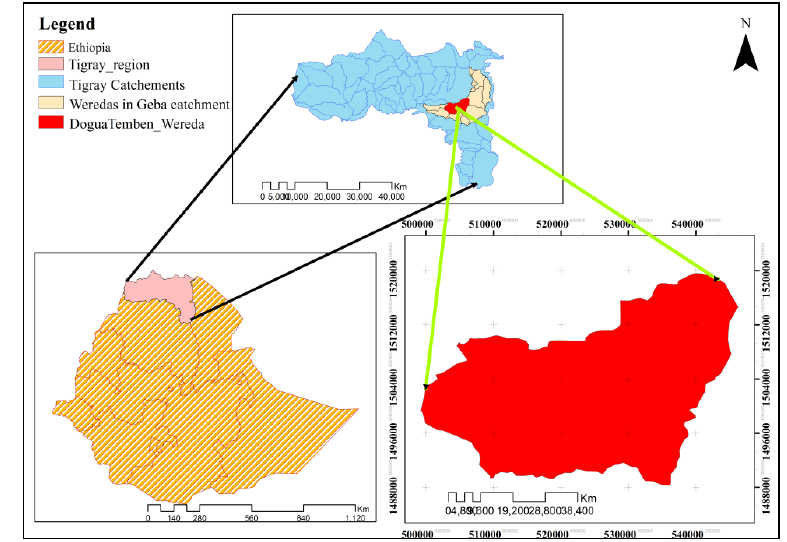
Figure 1. Location map of the study area.